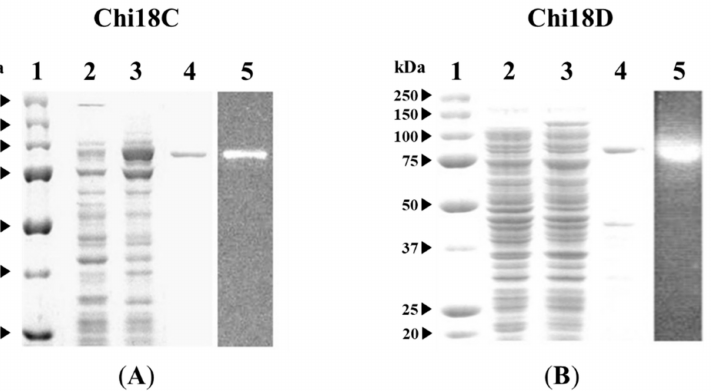
Figure 17. SDS-PAGE (Lanes 1–4) and activity staining after renaturation treatment of chitinase (Lane 5) expressed in E. coli BL21 (DE3) harboring pET-28a(+)/ chi 18C ( A ) or/ chi 18D ( B ). Each panel represents: Lane 1, standard marker; Lane 2, the crude extract from each clone; Lane 3, the crude extract from each clone induced by IPTG; Lane 4, the purified chitinase using an Ni-NTA column from each clone; Lane 5, activity staining of the purified chitinase Chi18C or Chi18D from each